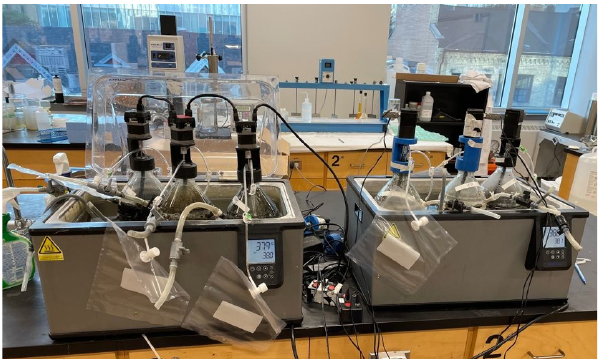
Figure 2. Setup of the fermentation reactors inside temperature-controlled water baths and con- nected with mechanical mixers and biogas collection